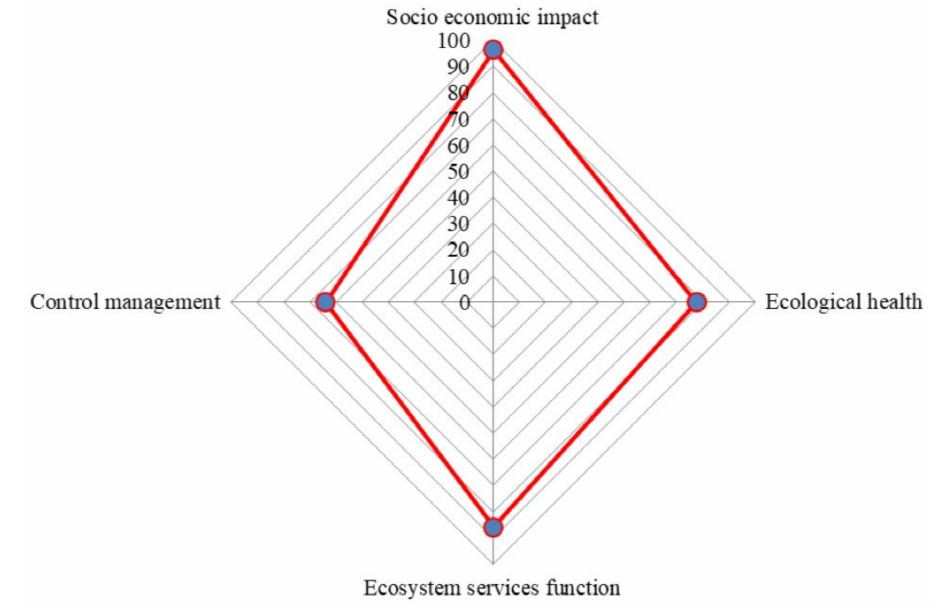
Figure 5. Radar diagram for the four factors in the SEEC